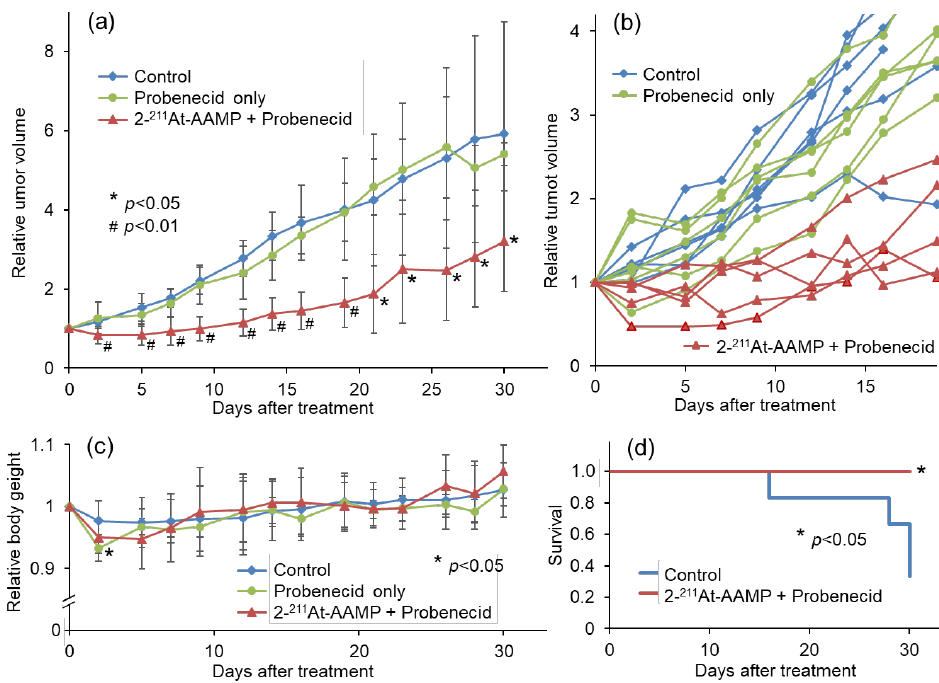
Figure 6. Therapeutic effect of 2 MBq 2- 211 At-AAMP in tumor-bearing mice with or without intraperitoneal injection of probenecid (mean ± SD, n = 5–6). ( a ) Average tumor growth, ( b ) individual tumor growth, ( c ) average body weight change, and ( d ) Kaplan–Meier survival curves after treatment. * p < 0.05 and # p < 0.01 compared with the control group.